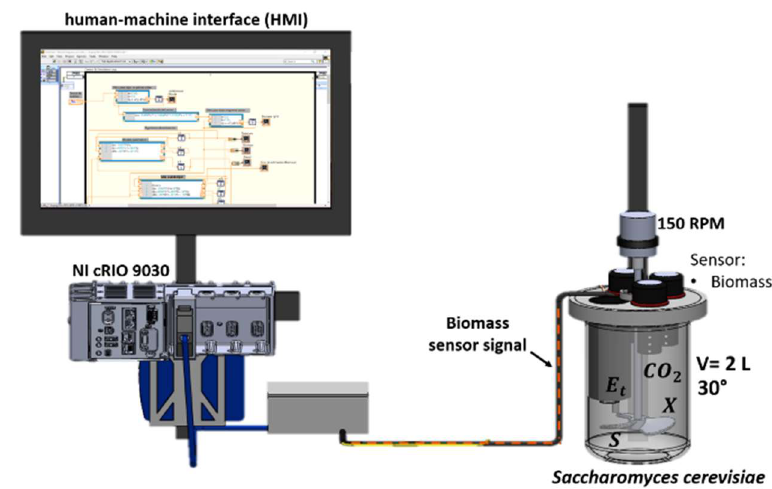
Figure 3. Schematic of the experimental setup in batch operation.